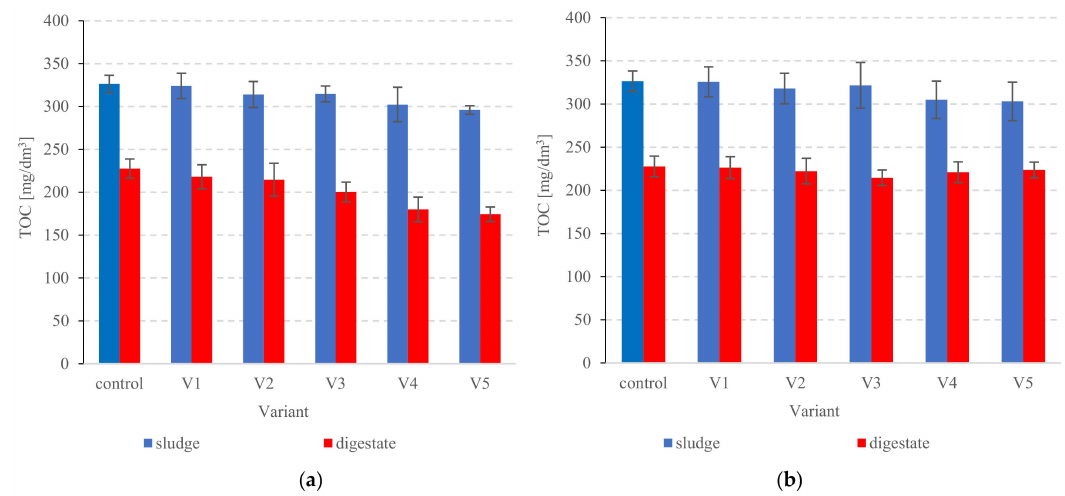
Figure 8. TOC in the sludge and digested PSS in ( a ) series 1, and ( b ) series 2.